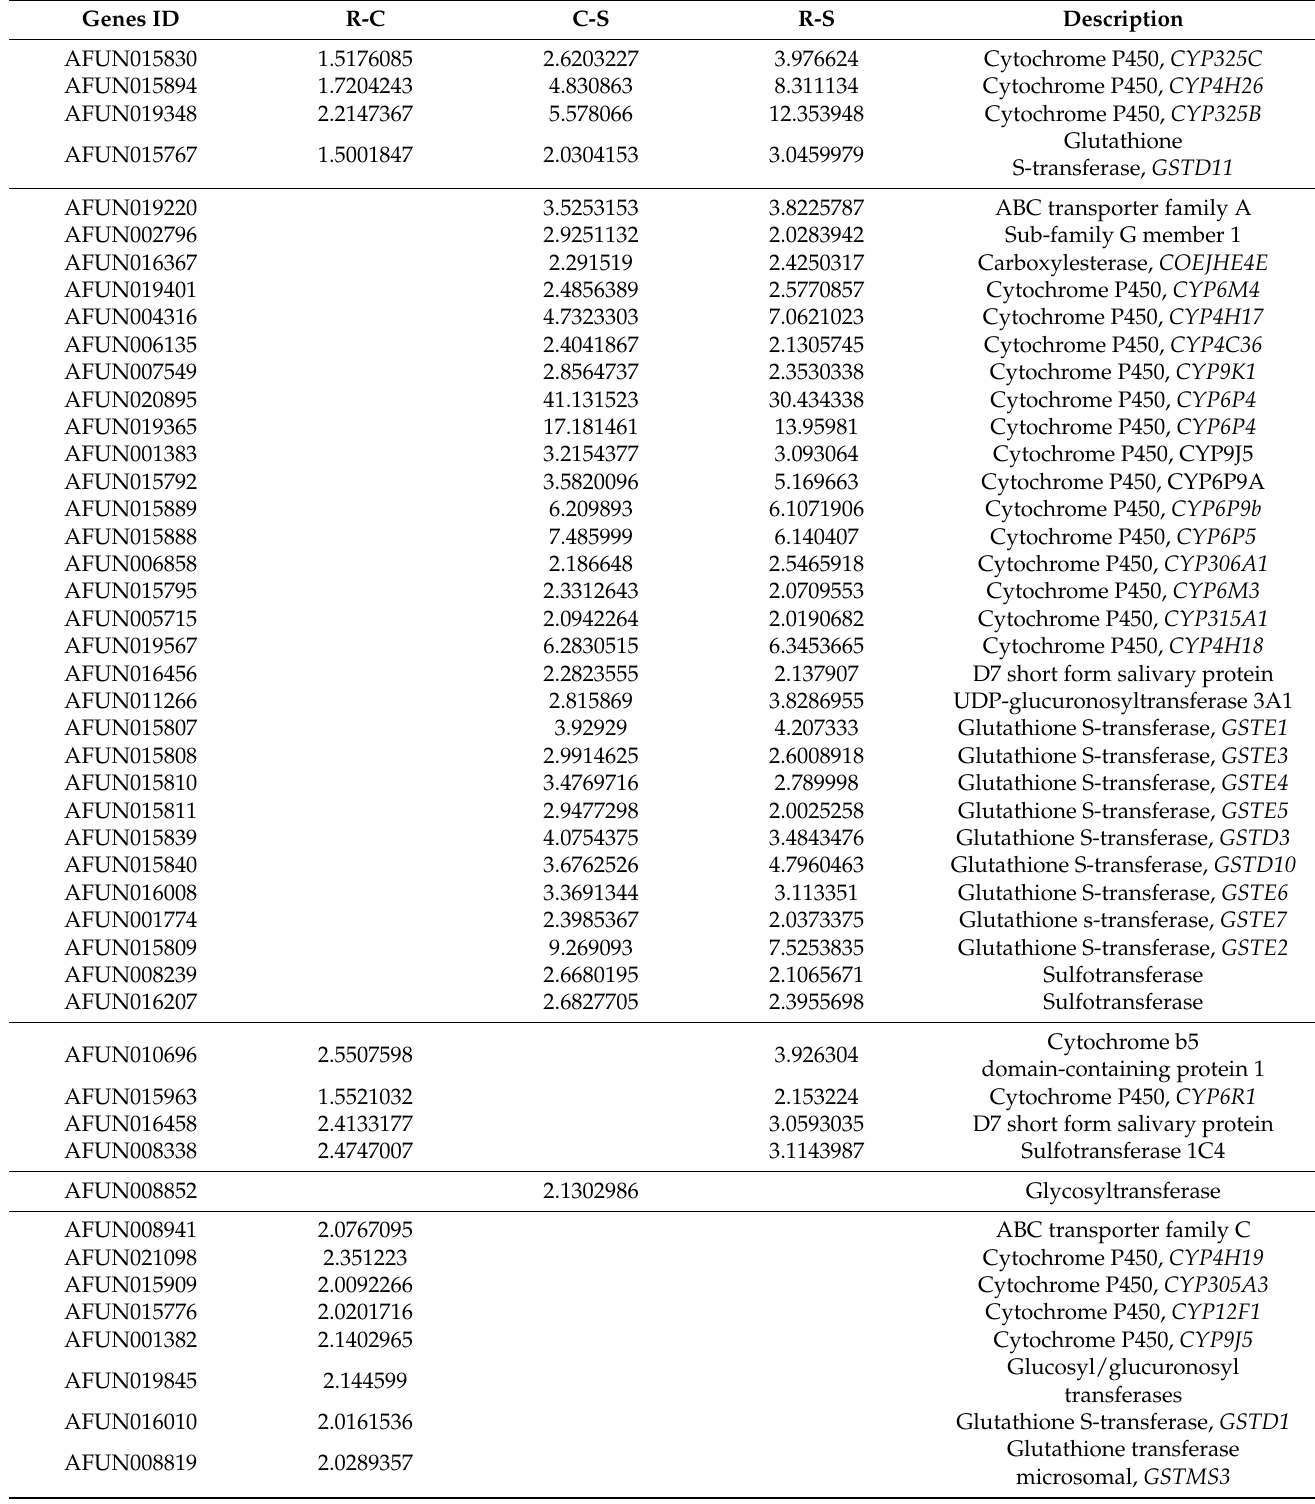
Table 2. Detoxification genes differentially expressed in Ghana between different comparisons at FDR < 0.05 and FC > 1.5 for R-C or FC > 2 for C-S and